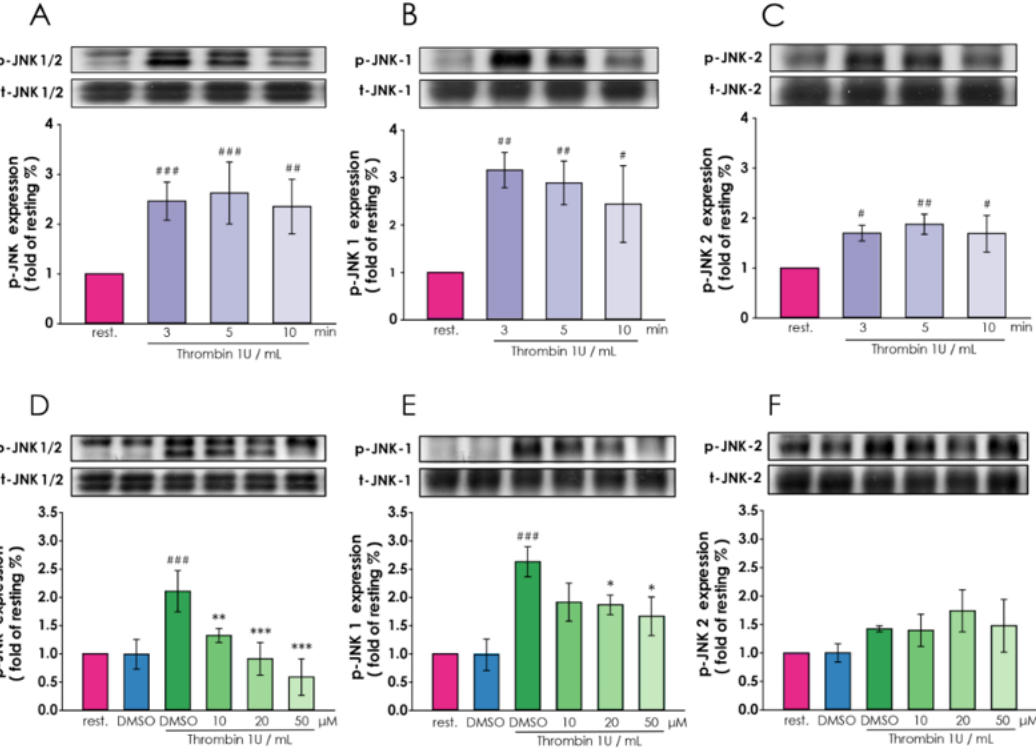
Figure 3. Regulatory roles of magnolol in thrombin-induced c-Jun N-terminal kinase (JNK) expression